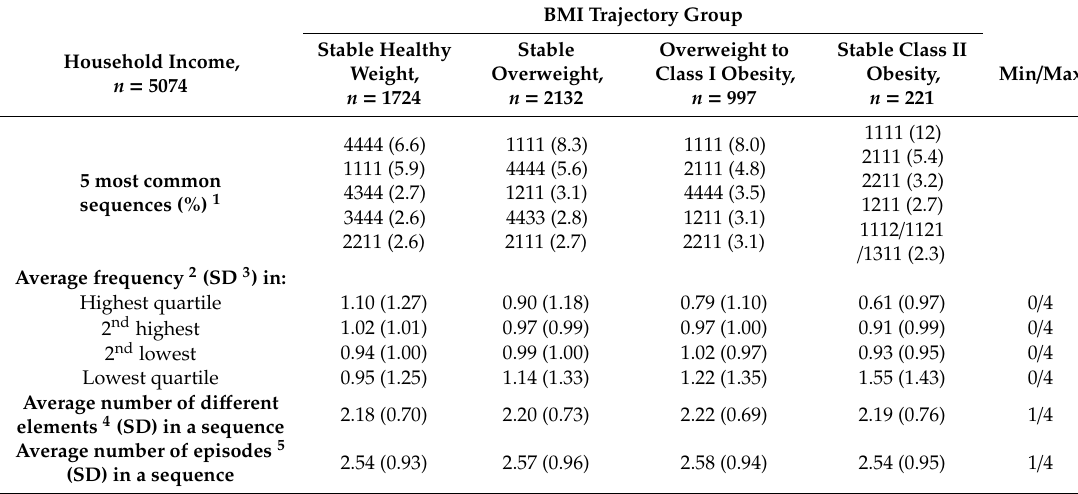
Table 2. Characteristics of sequences in household income by the body mass index (BMI) trajectory groups over the follow-up